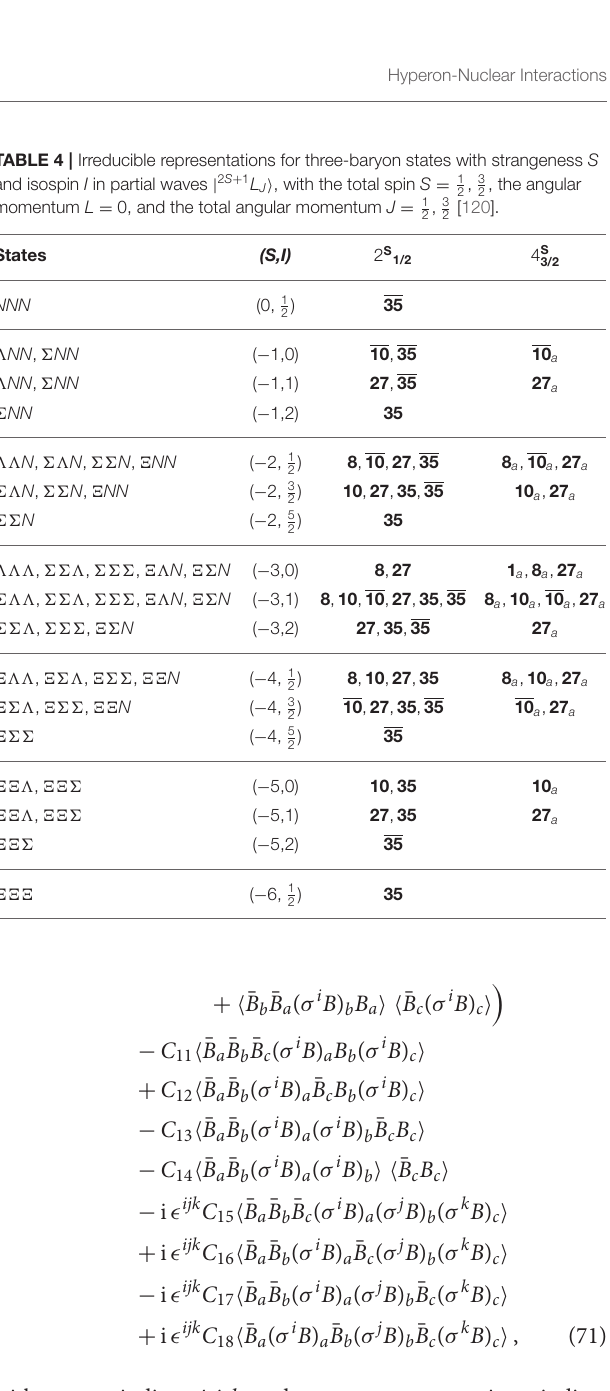
2 S + 1 L J , with the total spin S | i